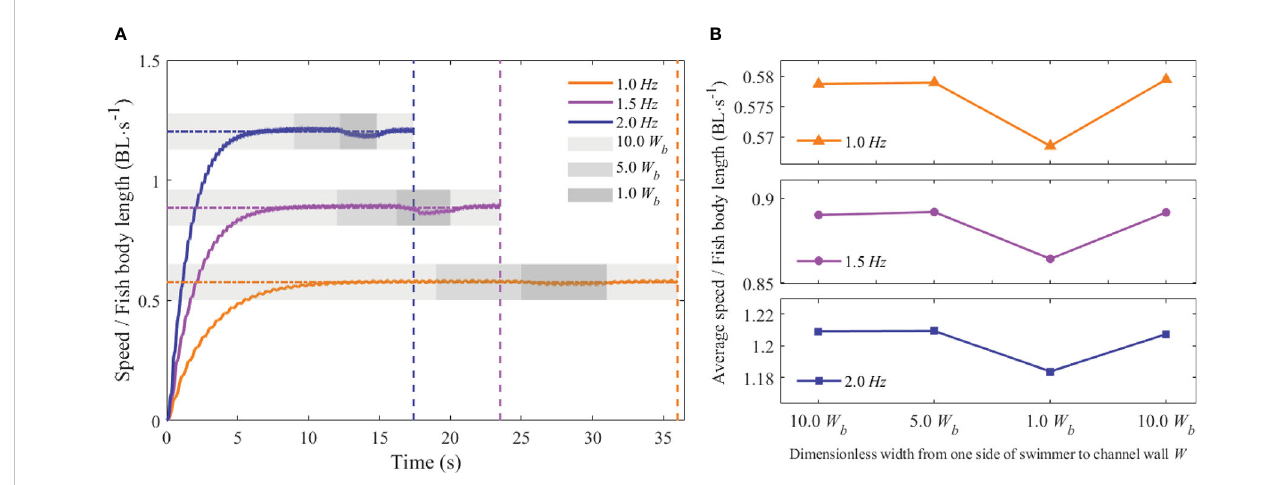
FIGURE 9 Forward speed of the swimmer at different values of f and W . (A) Instantaneous forward speed (B) Average forward